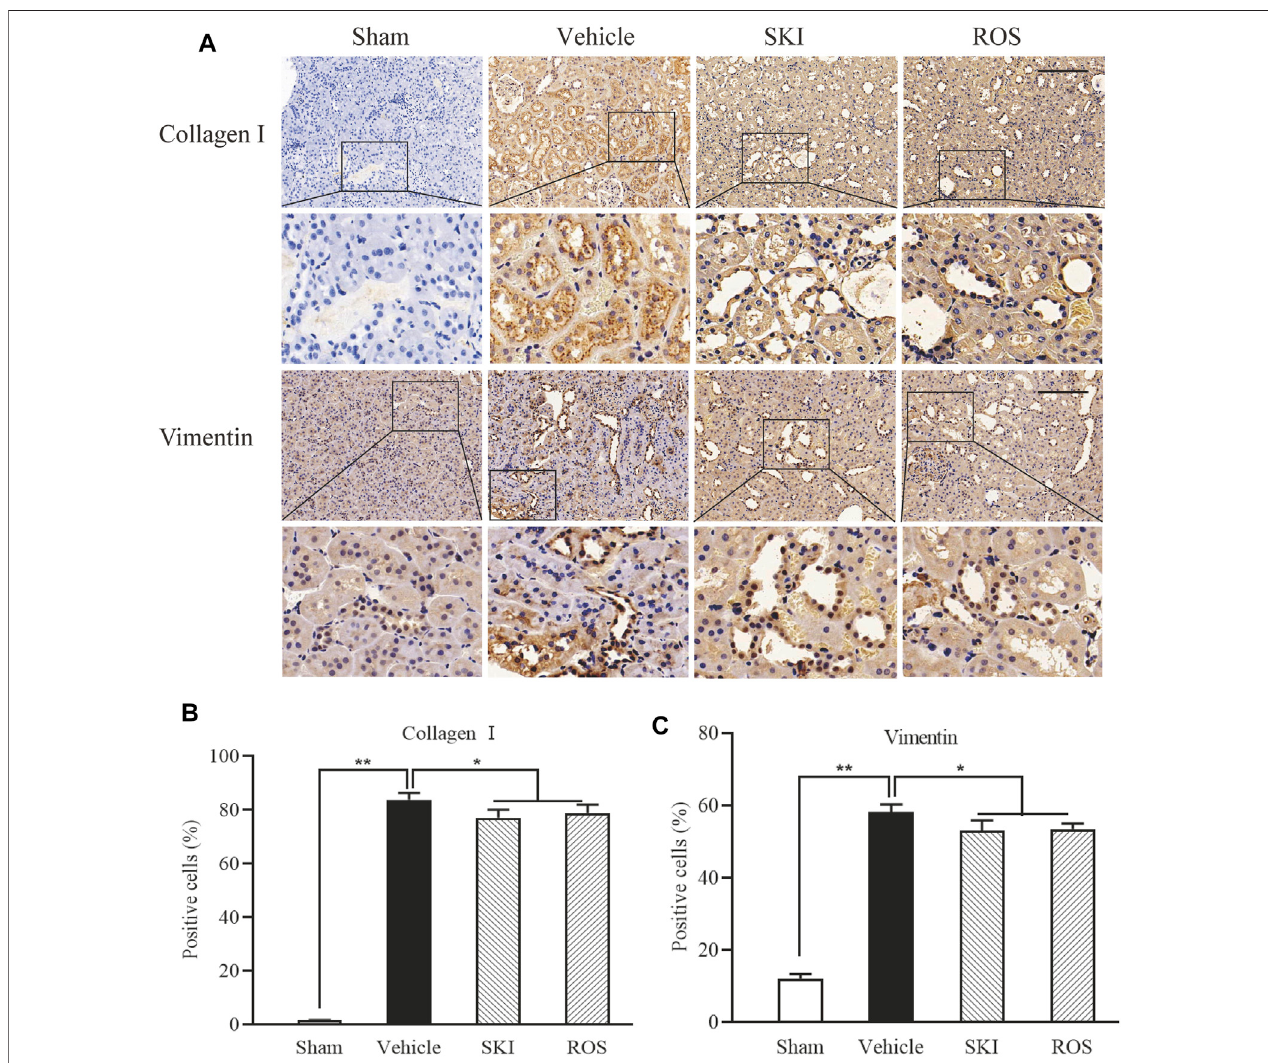
FIGURE 6 | The effects of SKI and ROS on the expression levels of collagen I and vimentin in vivo . (A) Immunostaining of collagen I and vimentin in the kidney ( × 200); (B,C) Thenumberofpositivelystainedcells.Scalebar (cid:2) 100 μ m.Dataareexpressedasmean ± S.E.* p < 0.05,** p < 0.01.Abbreviations:collagenI,collagentype I; ROS, rosiglitazone; SKI, Shenkang injection.